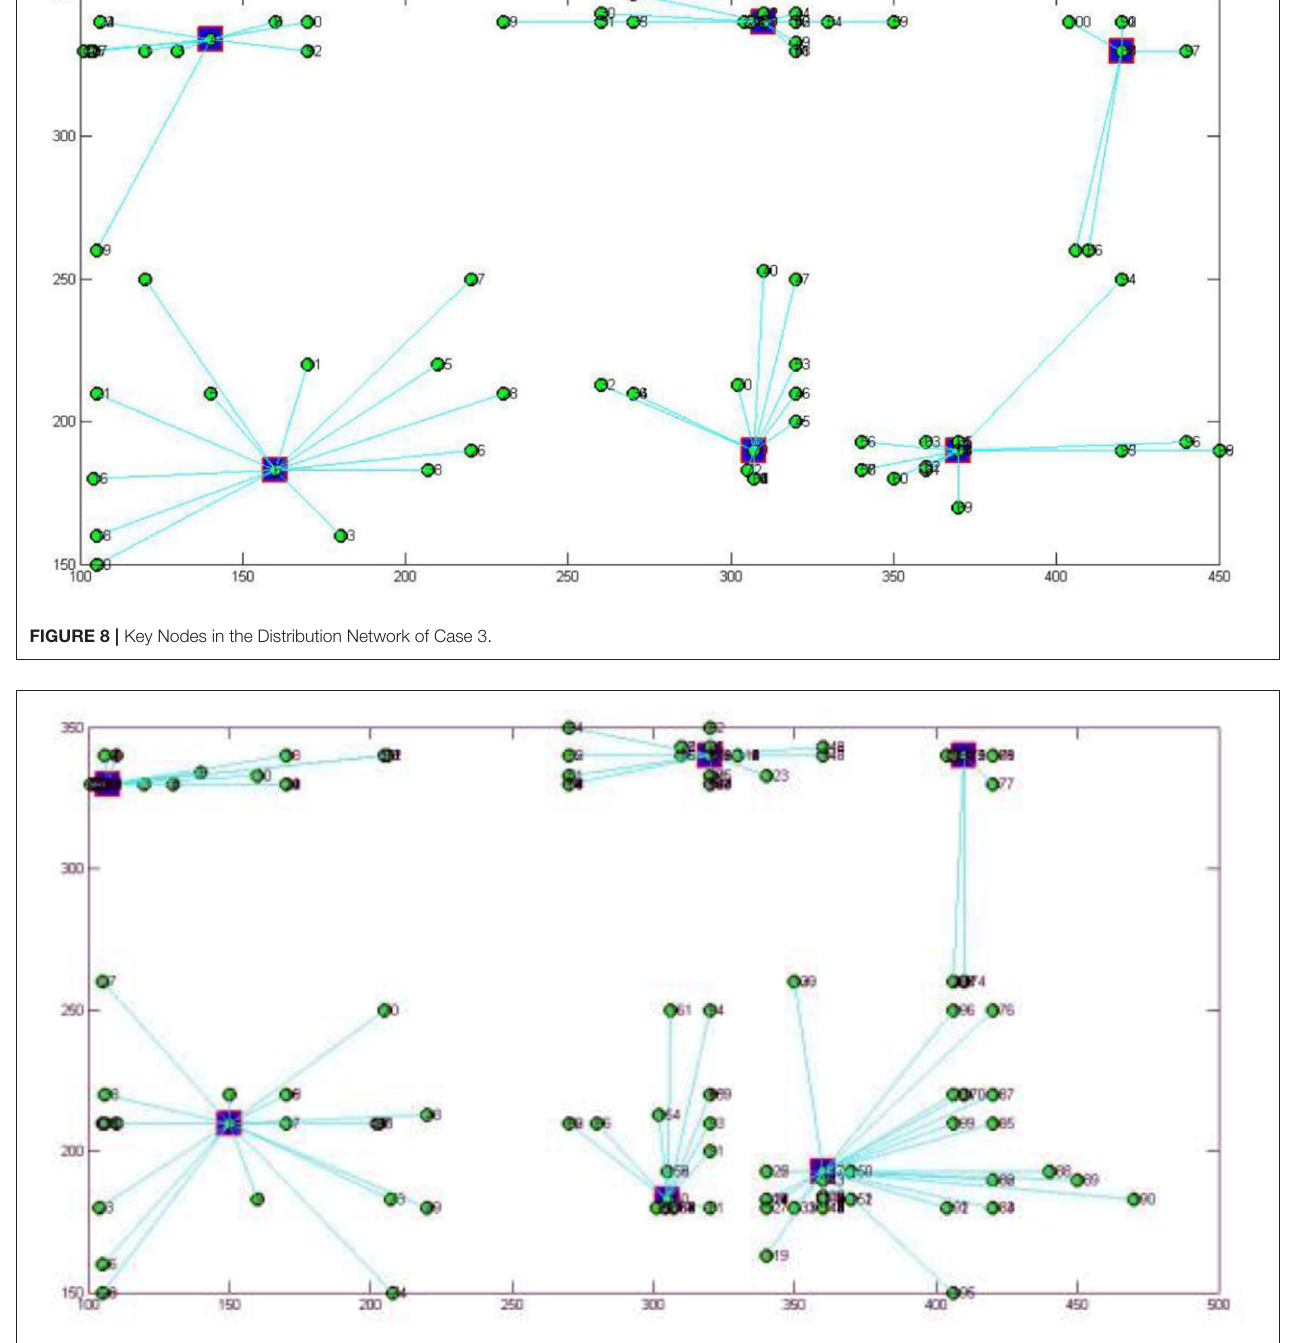
FIGURE 9 | Key Nodes in the Distribution Network of Case